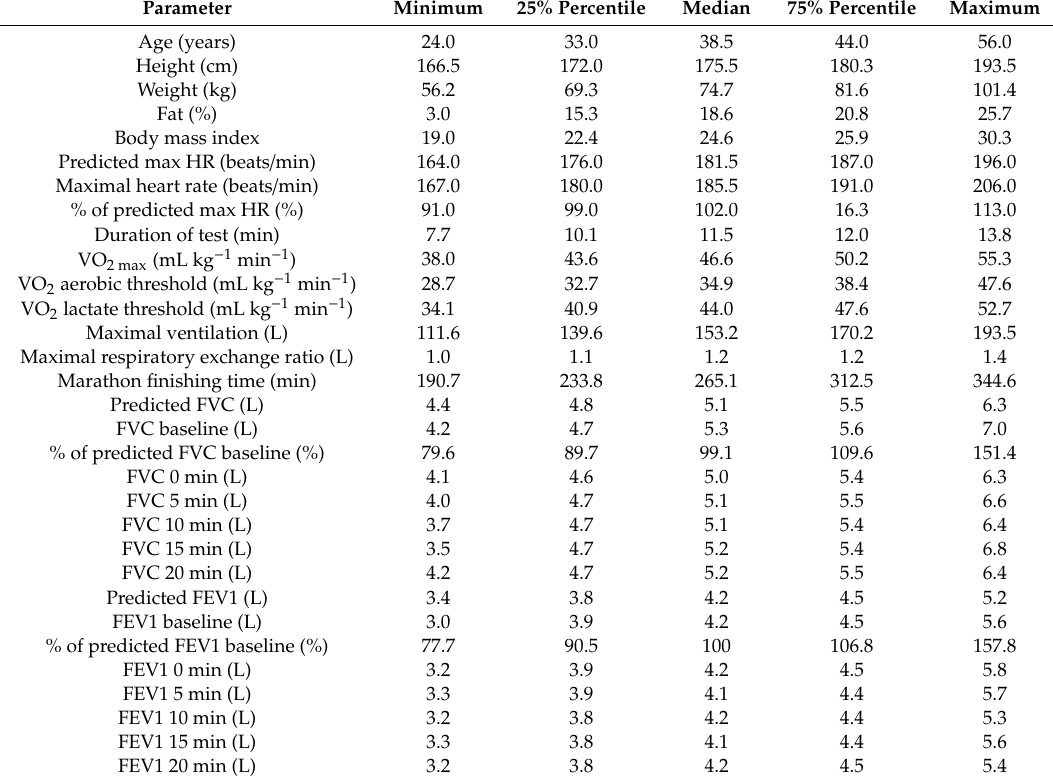
Table 1. Anthropometric data, aerobic capacity, and pulmonary function of all volunteers—International Marathon of Sao Paulo